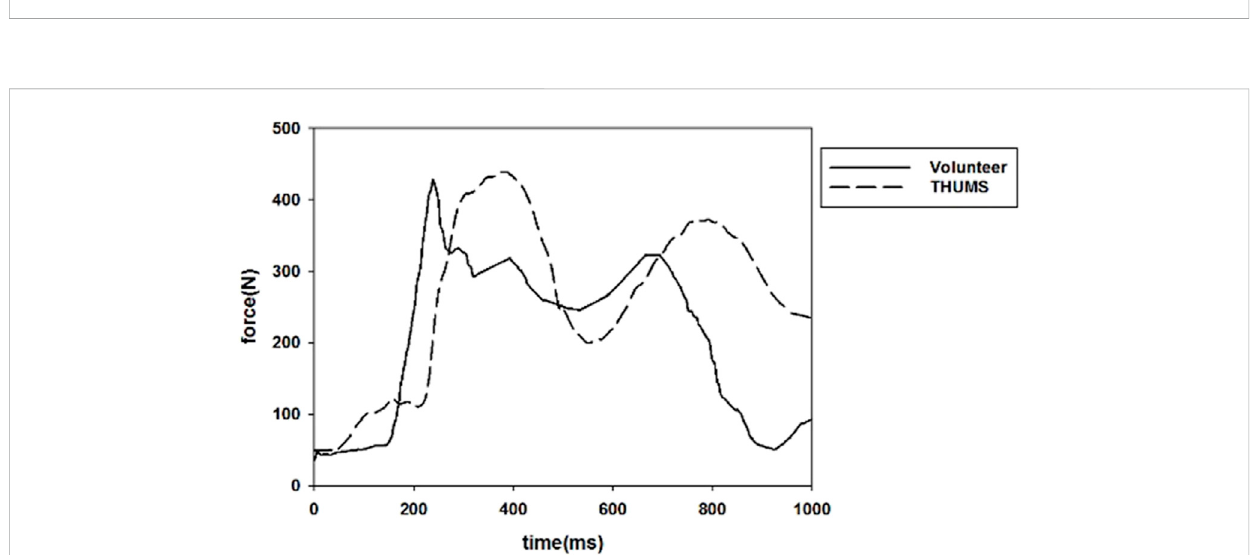
FIGURE 7 Neck movement during pre-crash.